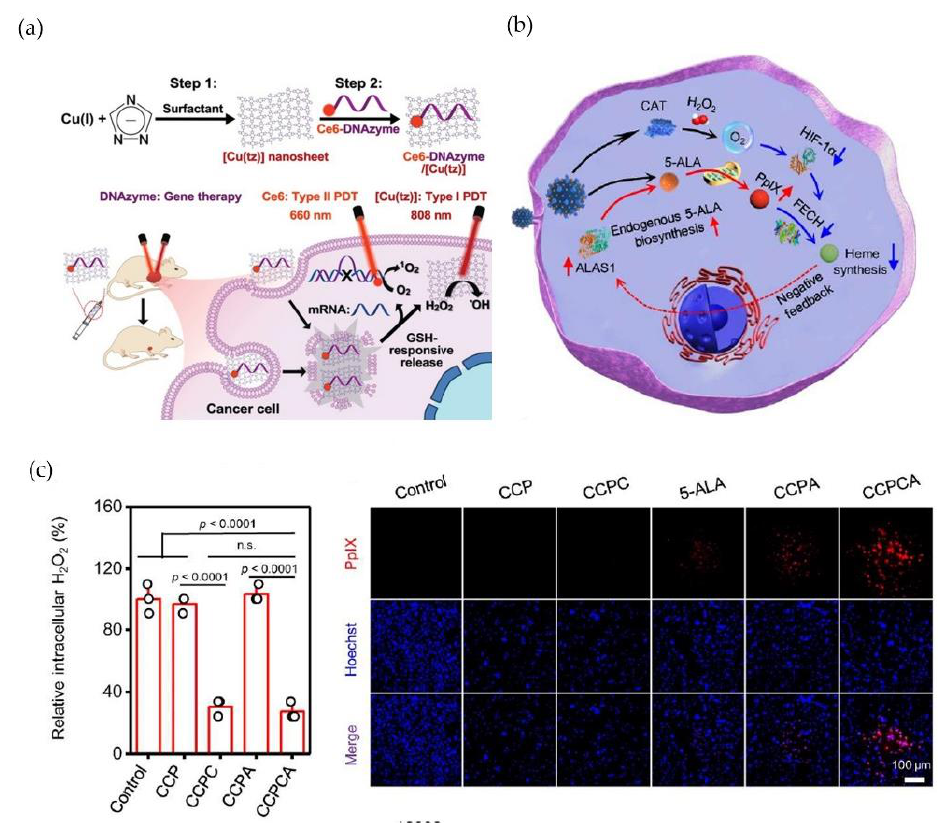
Figure 8. ( a ) Ce6-DNAzyme/[Cu(tz)] triggers both Type-I and Type-II PDT, as well as selective gene silencing by DNAzyme. ( b ) Illustration of heme negative feedback mechanism of CCPCA NPs. ( c ) CCPCA exhibited lower H 2 O 2 content and RDPP expression (the study of intracellular O 2 ), suggesting sufficient intracellular O 2 generation ability (n.s. represents no signigicance). Reprinted with permission from Refs. ( a ) [94] 2021 John Wiley and Sons and ( b , c ) [96] 2022 Springer Nature.